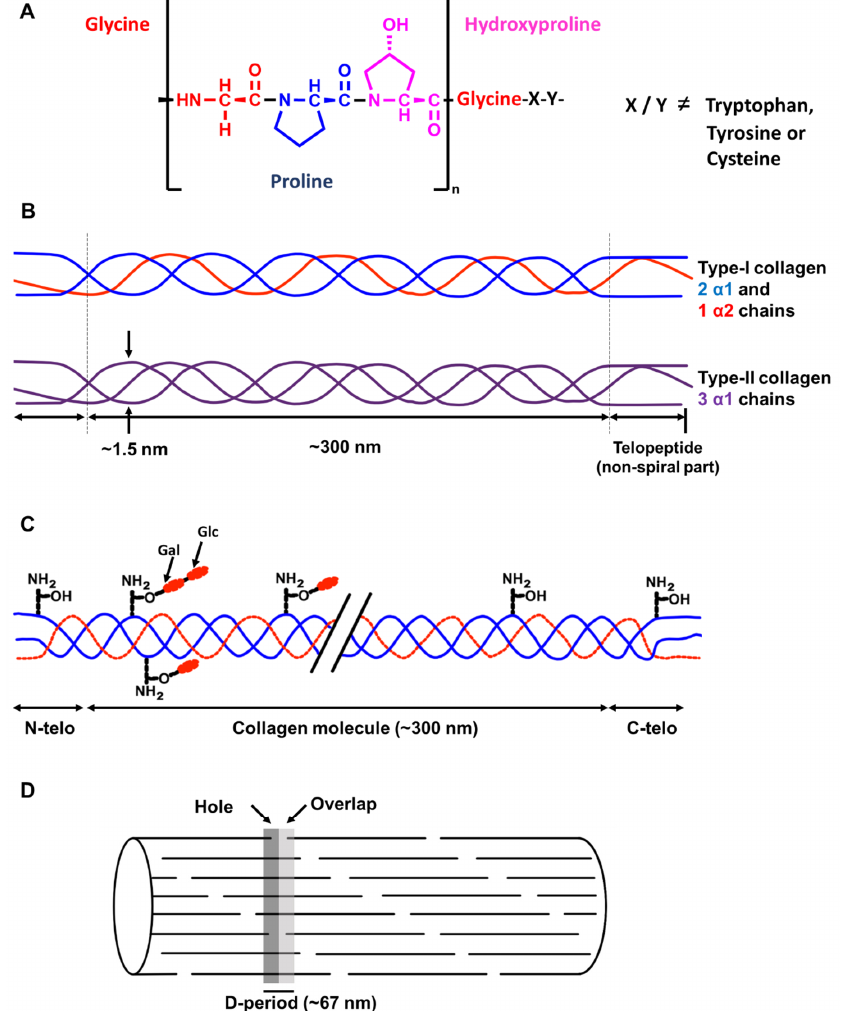
Figure 4. ( A ) The most common repeating sequence present in collagen types I and II. Positions X and Y can be occupied by any amino acid except tryptophan, tyrosine or cysteine. The most common amino acids in positions X and Y are proline and hydroxyproline, respectively. ( B ) Schematic representation of the triple helical structure of collagens type I and II. In collagen type I, there are two α 1 chains and one α 2 chain, whereas in collagen type II, there are three α 1 chains. ( C ) Diagram of a collagen molecule showing the post-translational modifications that occur, which are hydroxylation of lysine residues and glycosylation of hydroxylysine by galactose and glucose. ( D ) The stacked arrangement of collagen fibers, visible under a transmission electron microscope, shows a characteristic staggered pattern known as the D-band or D-period of approximately 67 nm in periodicity. This banding is a unique feature used for identification of collagen fibers under the microscope. Adapted from [110,111].